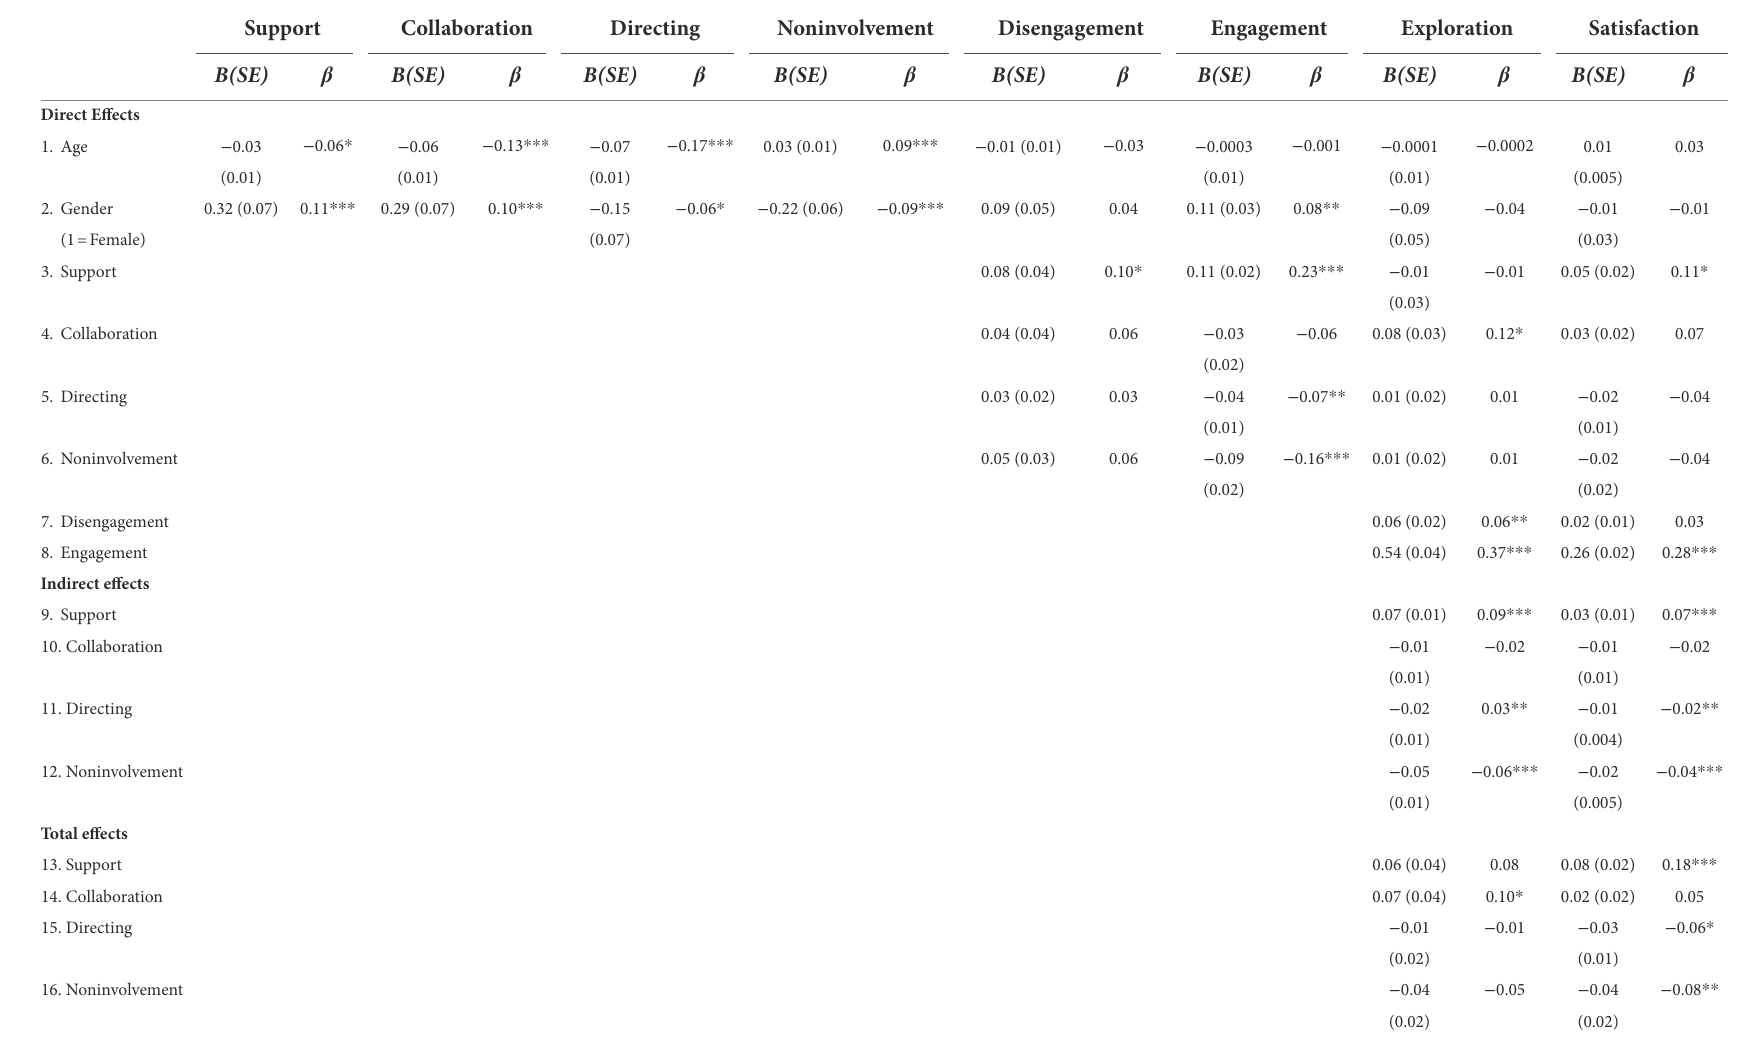
TABLE 3 Direct, indirect, and total effects of shared and nonshared agency from mothers on occupational